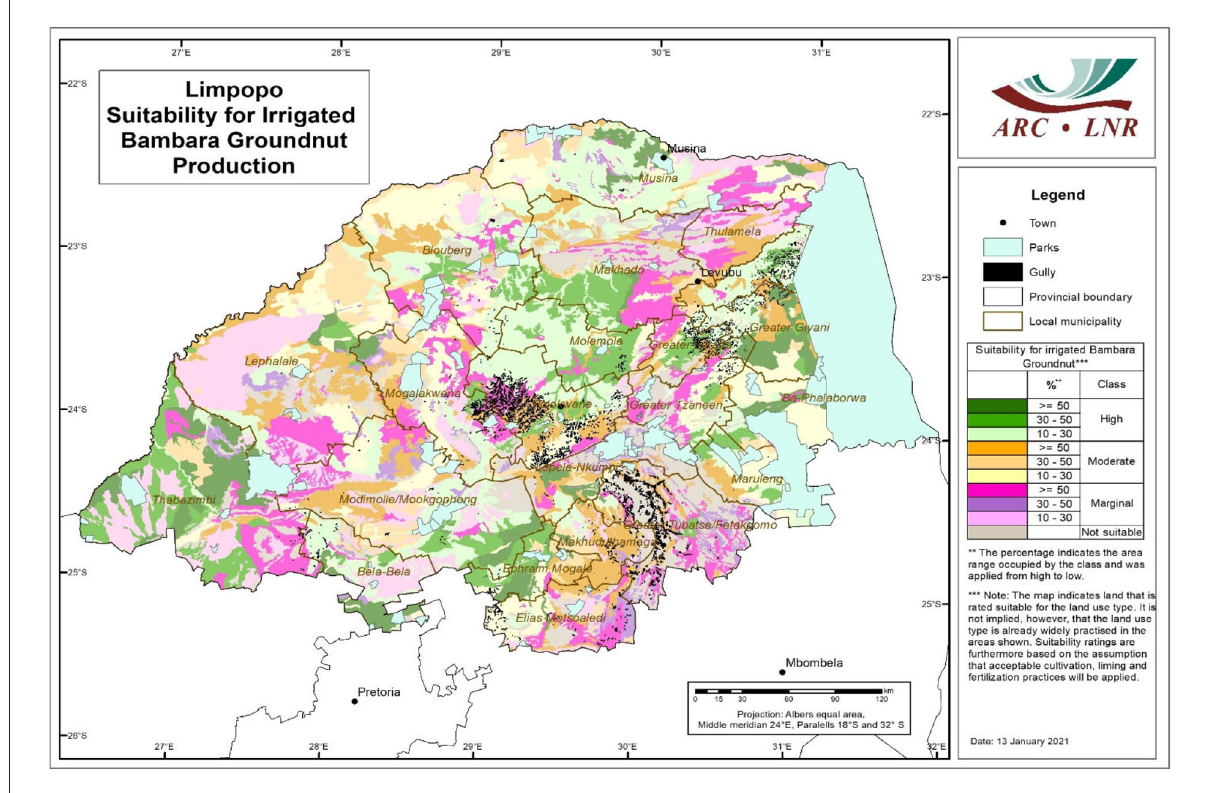
FIGURE5 Incidence of gullies mapped in Limpopo